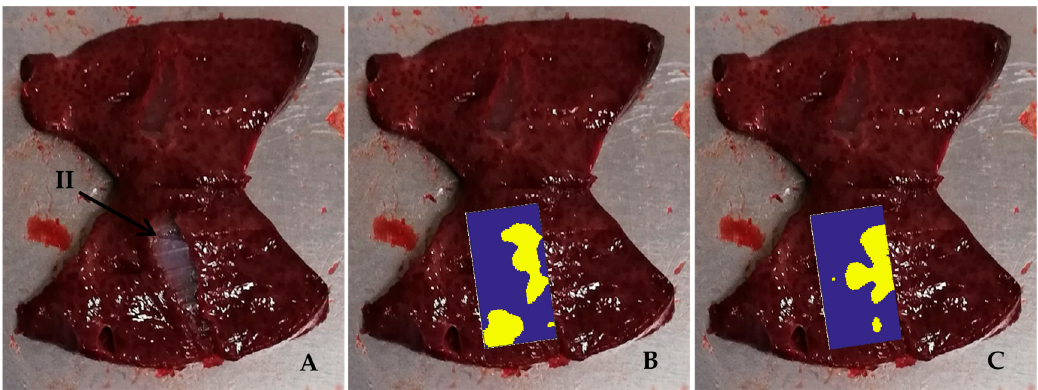
Figure 10. Analysis of the liver tissue sample #2. ( A ) Sample divided into two pieces with marked inclusion of type II; ( B ) CIA and ( C ) CIS maps overlapped to the scanned area over the inclusion.